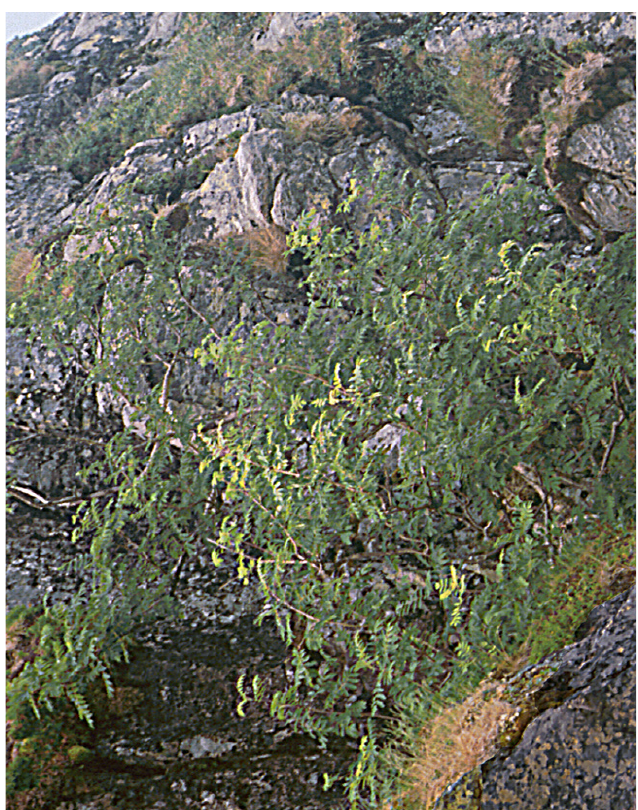
Figure 46: Tempelglaciären (2). Shrubby rowan ( Sorbus aucuparia ) growing in a favourable local climate on a cliff ledge at the backwall of the glacier